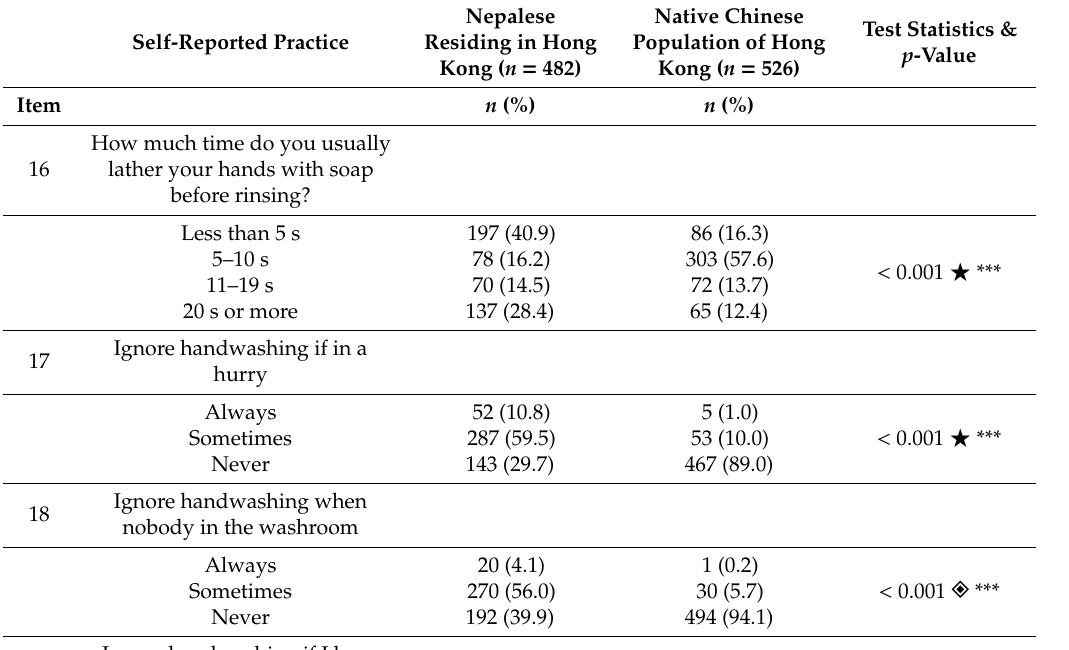
Table 2. Knowledge level on hand hygiene (0 to